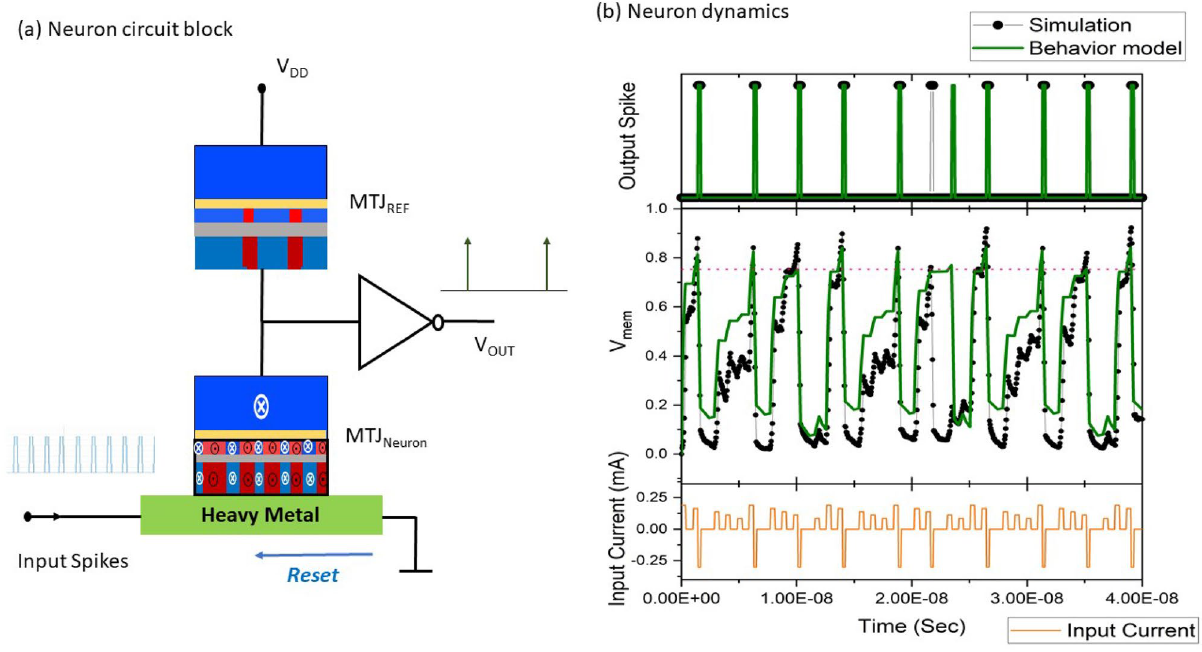
Figure 4. ( a ) The spiking neuron circuit block incorporating the proposed multi-domain SOT-MTJ. ( b ) Demonstration of leaky integrate and fire dynamics in micro-magnetic simulation. The spiking dynamics is also reproduced by the behavior model. The firing threshold of V mem is set at